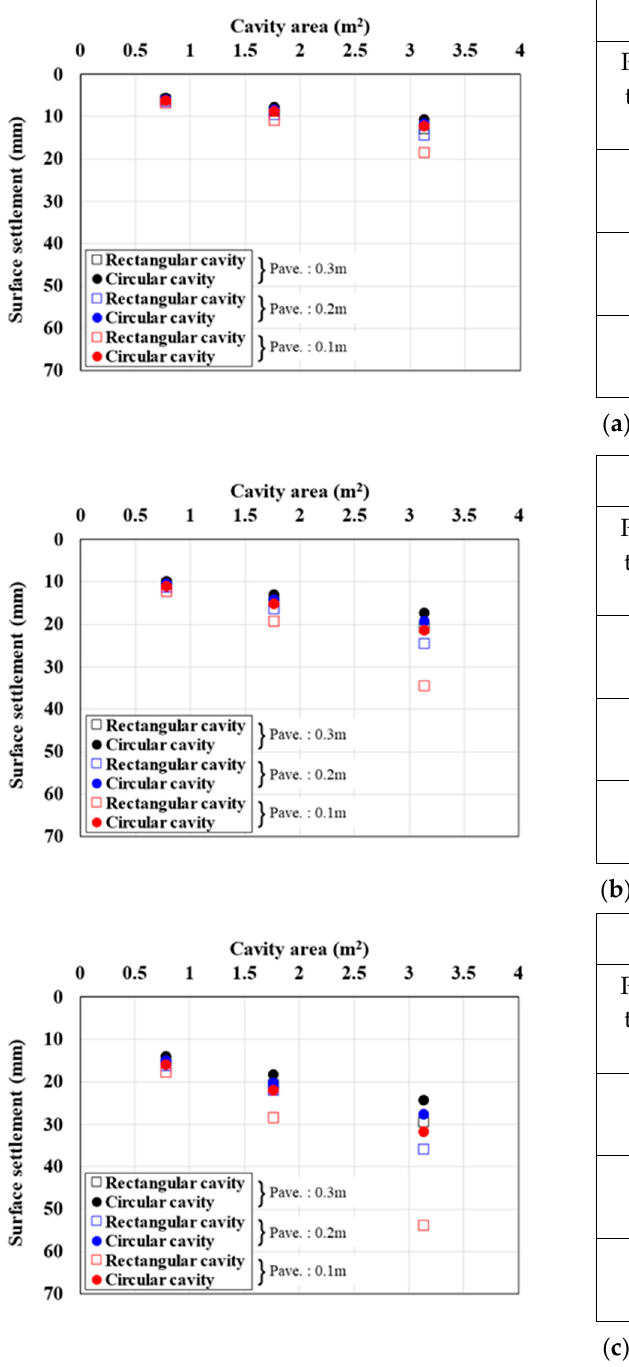
Figure 8. Surface settlement according to cavity area by pavement thickness (pavement elastic modulus: 1000 MPa). Traffic load: ( a ) 12.7, ( b ) 25.4, and ( c ) 38.1 kN/m 2 .